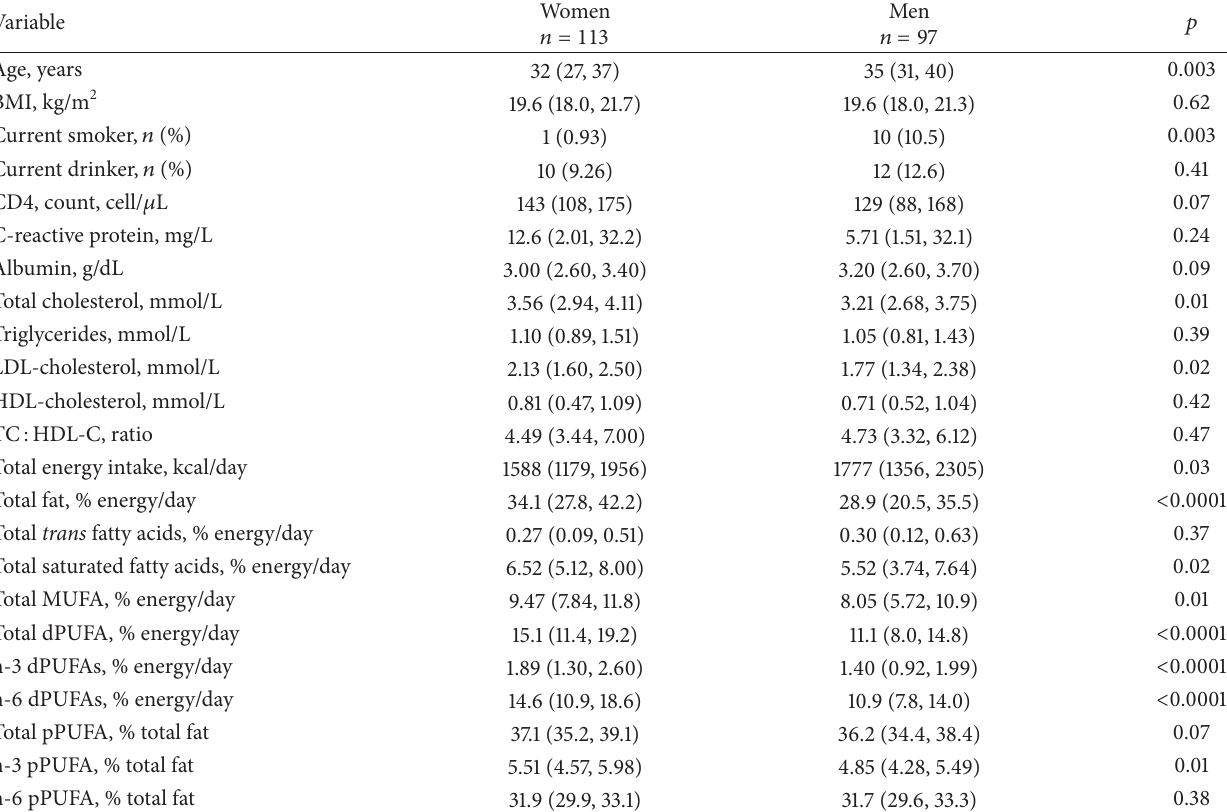
Table 1: Baseline characteristics of the study population.